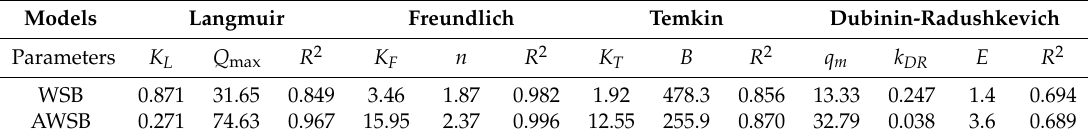
Table 2. Parameters of adsorption isotherm models at constant temperature (room temperature), pH 6 and optimum dose of WSB (dosage = 2 g / L) and AWSB (dosage = 1 g / L).